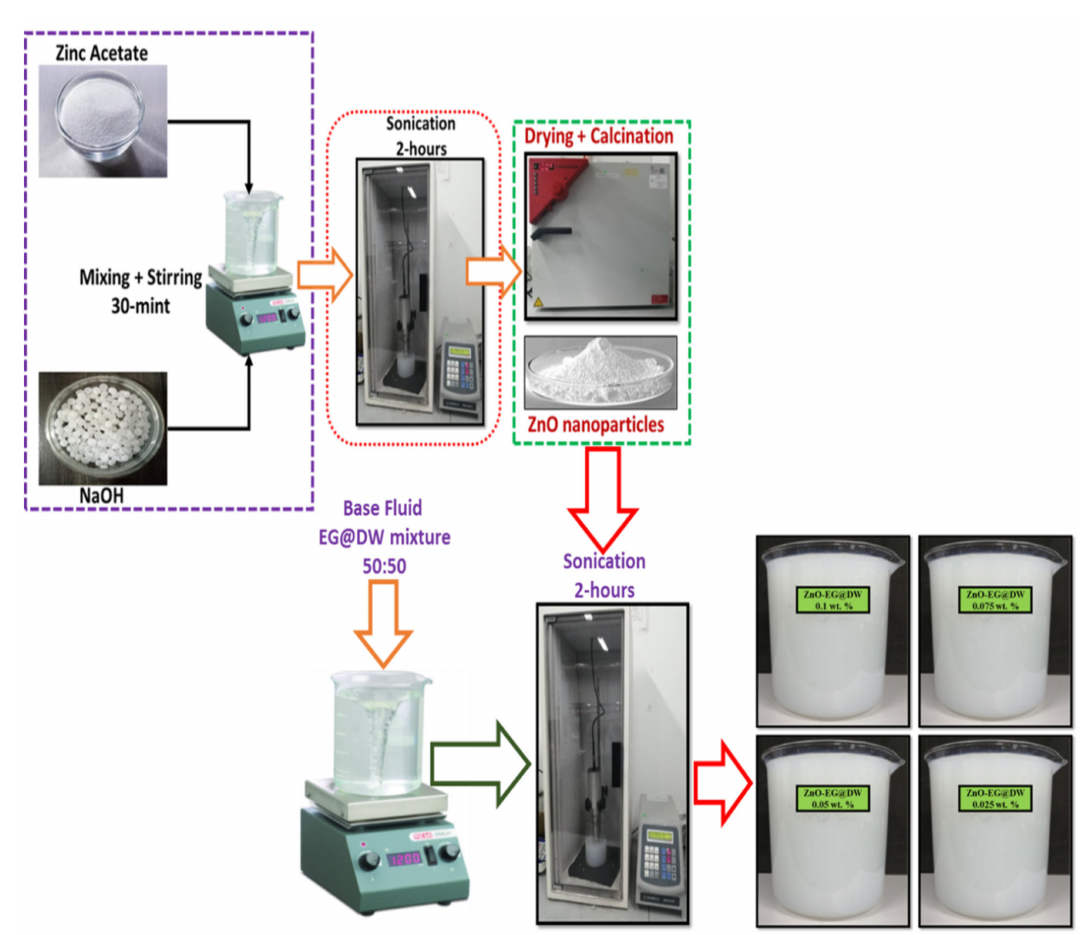
Figure 1. One-pot facile synthesis of ZnO nanoparticles and preparation of ZnO-EG@DW-based nanofluids with different wt.% (0.1, 0.075, 0.05 and 0.025) of